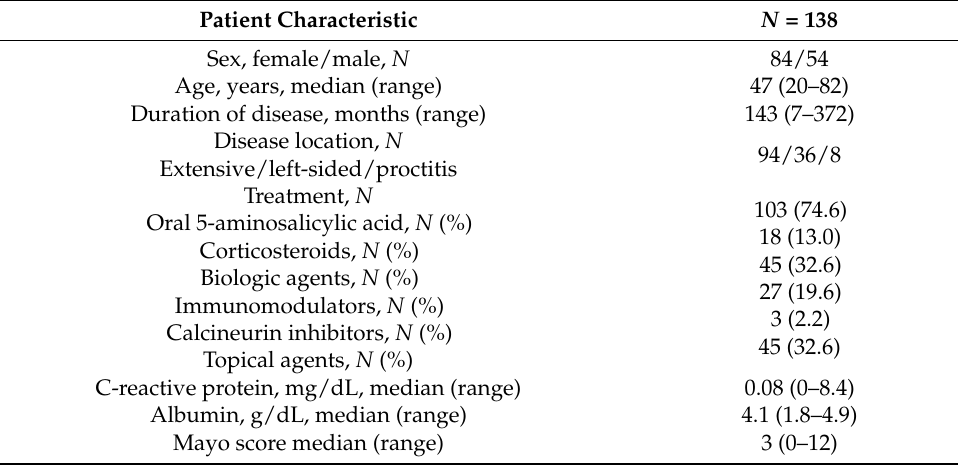
Table 1. Characteristics of patients with ulcerative